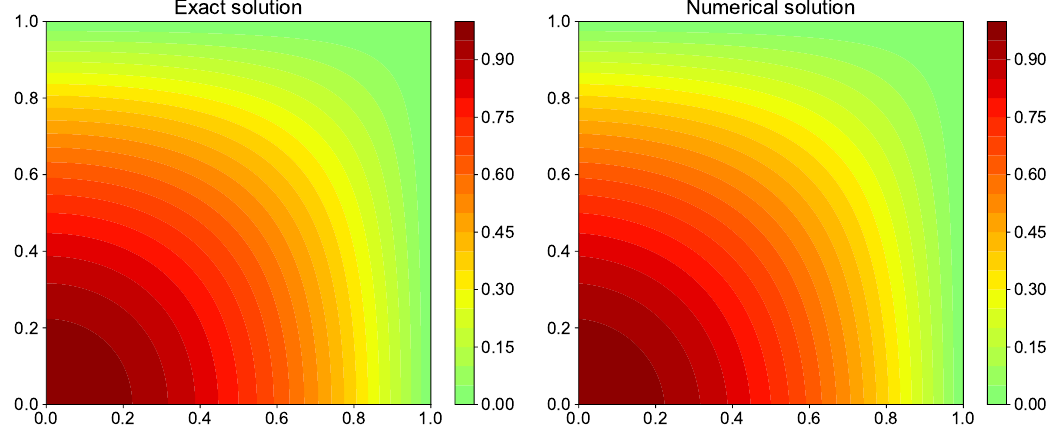
Figure 20. Comparison of exact solution and numerical solution computed using Gauss-Seidel iterative method for the Poisson